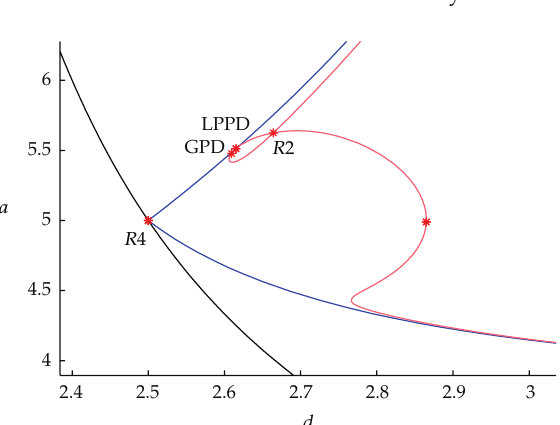
Figure 8: Twofold curves (cid:3) LP 4 (cid:4) of the fourth iterate emanate from an R4 point, and a flip curve of the fourth iterate (cid:3) PD 4 (cid:4) is rooted at an LPPD point.